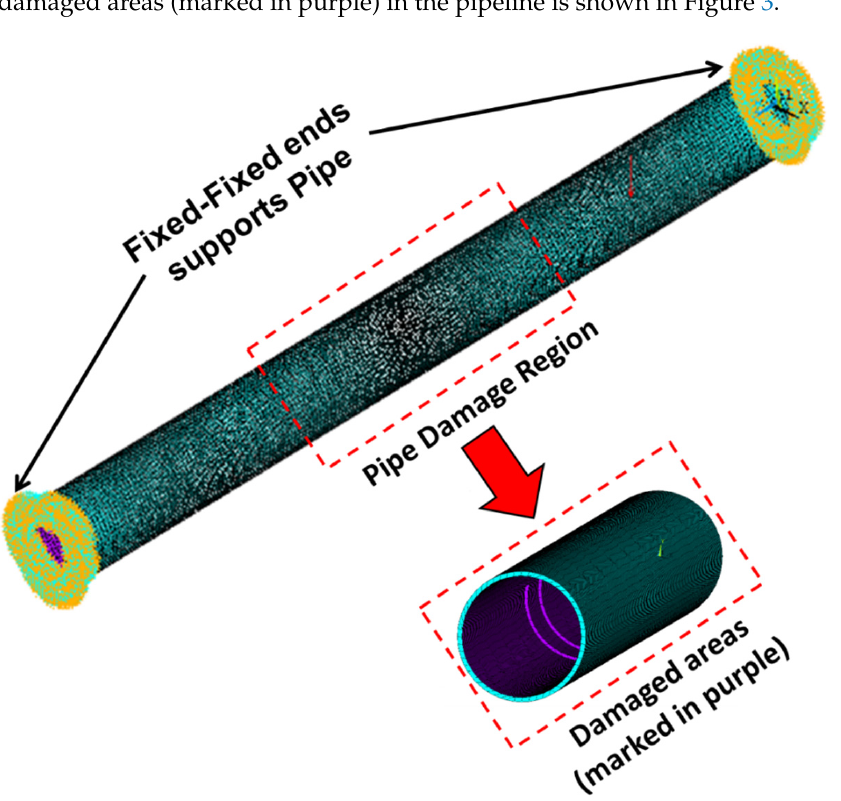
Figure 3. Fixed ends supporting pipe.